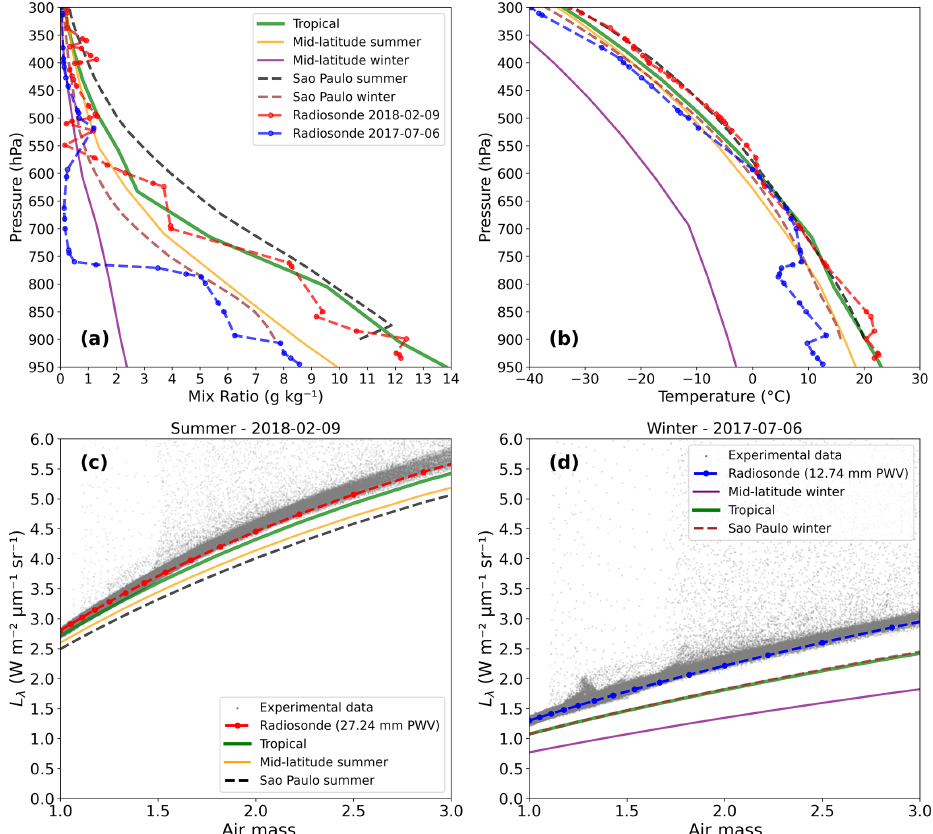
Figure 5. ( a ) Water vapor mixing ratio and ( b ) temperature vertical profiles for tropical (green), midlatitude summer (orange), and midlati- tude winter (purple) standard atmospheric models, as well as climatological averages for São Paulo in summer (black) and winter (brown), with examples for a summer day (9 February 2018, red) and a winter day (6 July 2017, blue). Measured L λ (gray) for ( c ) 9 February 2018 and ( d ) 6 July 2017, compared to libRadtran simulations for each atmospheric profile model. Radiance measurements were made within a few minutes from each 09:00LT radiosonde launch. Notice that São Paulo winter and tropical profile curves are nearly coincident in panel (d) . The simulations used the relative vertical moisture distribution in each profile, normalizing them to the PWV measured by the